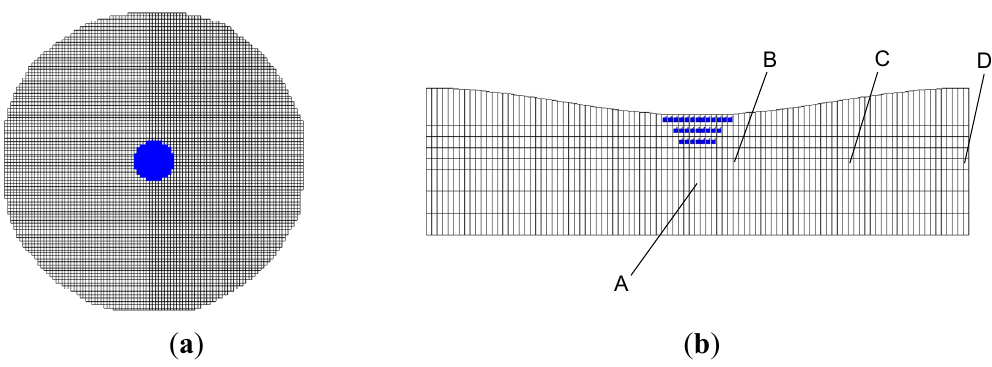
Figure 2. Panel ( a ) shows a top view of the grid with a lake positioned in the center of a circular watershed. The circular basin has a diameter of 5 km. Panel ( b ) shows 8 model layers with lake cells indicated by blue shading. A–D indicate reference cells where hydraulic head values are used to calculate response times.